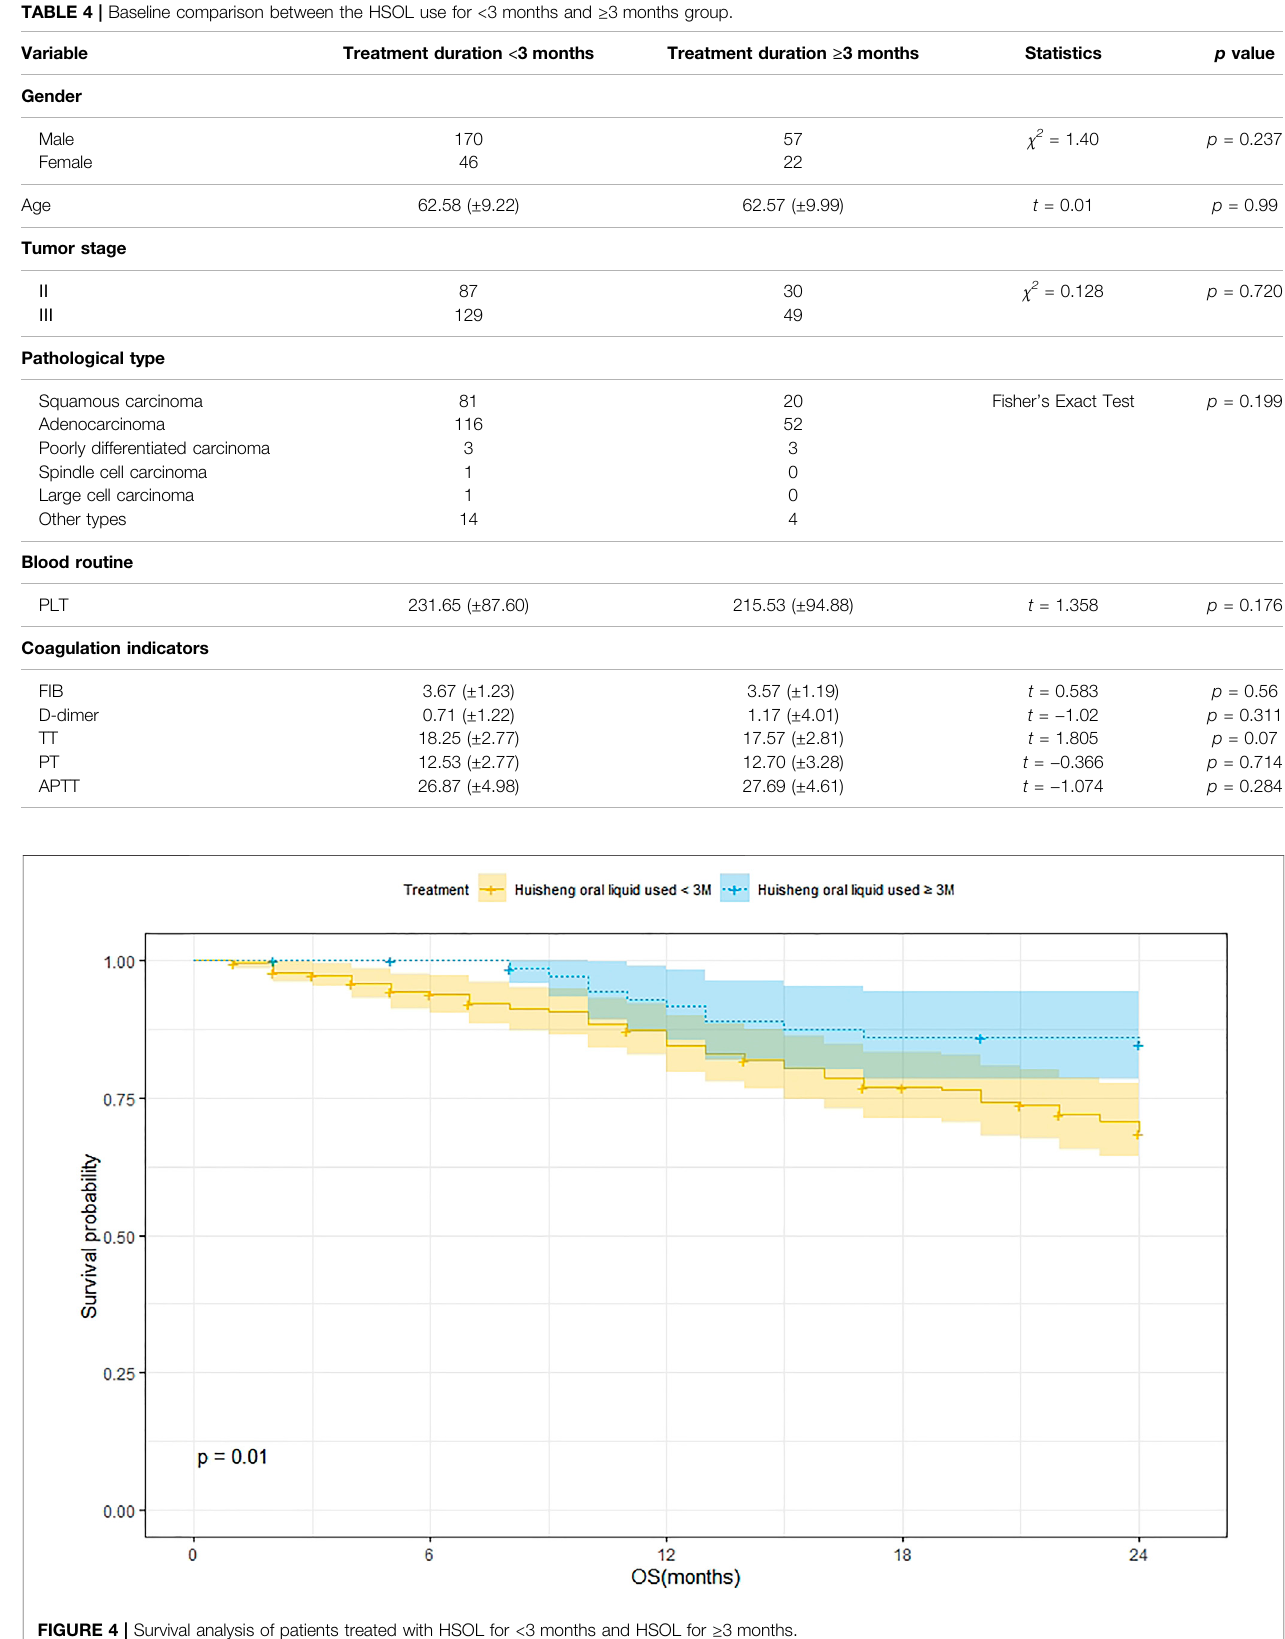
Frontiers in Pharmacology |